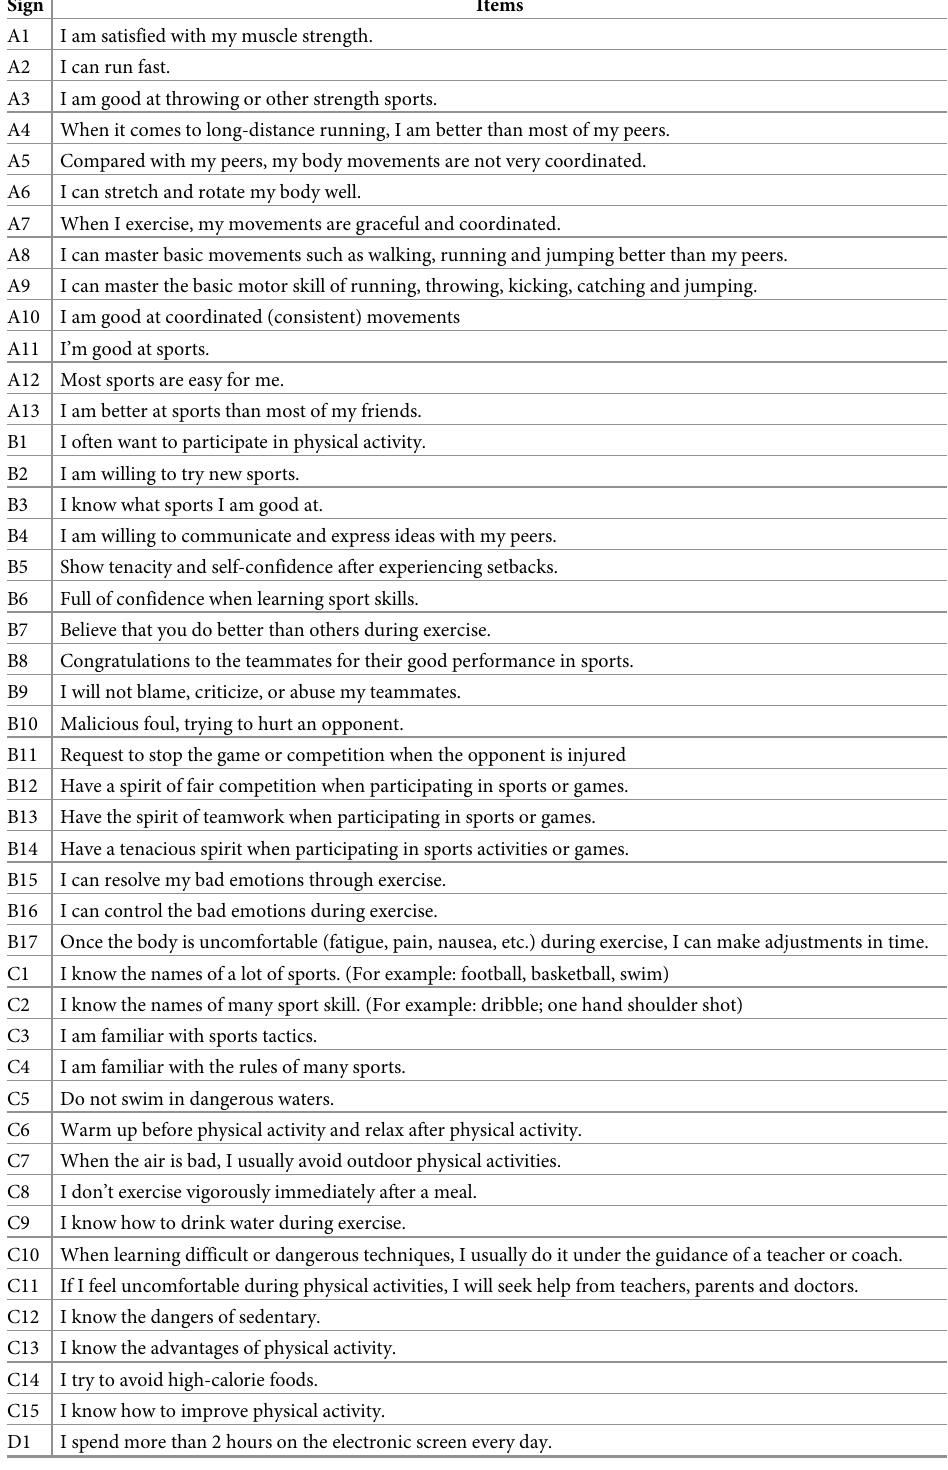
Table 1. Original 60-items of PLAQ for Chinese 3–6 grades